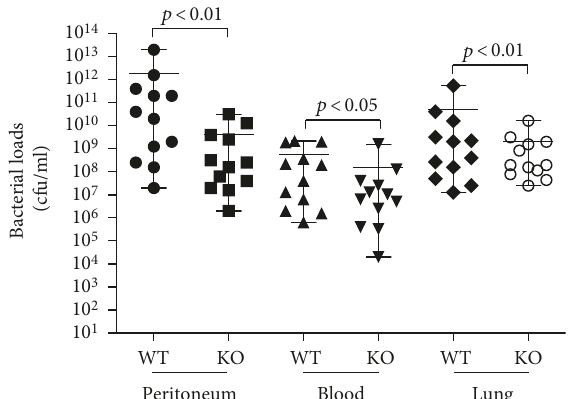
Figure 10: Lack of 5-HT decreases the bacterial loads in CLP-induced sepsis. The mice were anesthetized, and the peritoneal fl uid, blood, and lung tissue were collected to measure the bacterial loads 24h after the CLP. The bacterial loads were signi fi cantly decreased in the KO-CLP mice compared with the WT-CLP mice in the peritoneal fl uid, blood, and lung tissue. All data are expressed as the mean ± SD ( n = 6 , p < 0 05 versus the WT-CLP group).